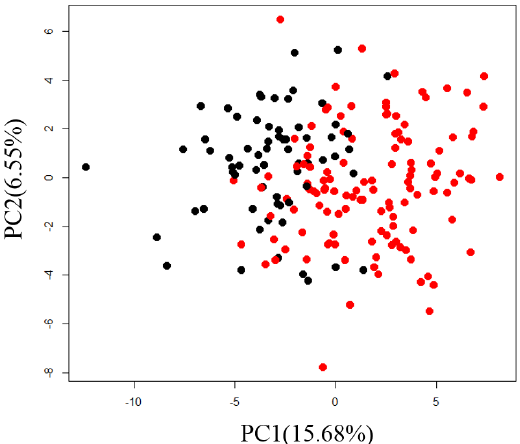
Figure 3. Scatter plot of PC1 and PC2 for normalized metabolome data from actual samples for individuals. Black circles are for samples from males and red circles are for samples from females.